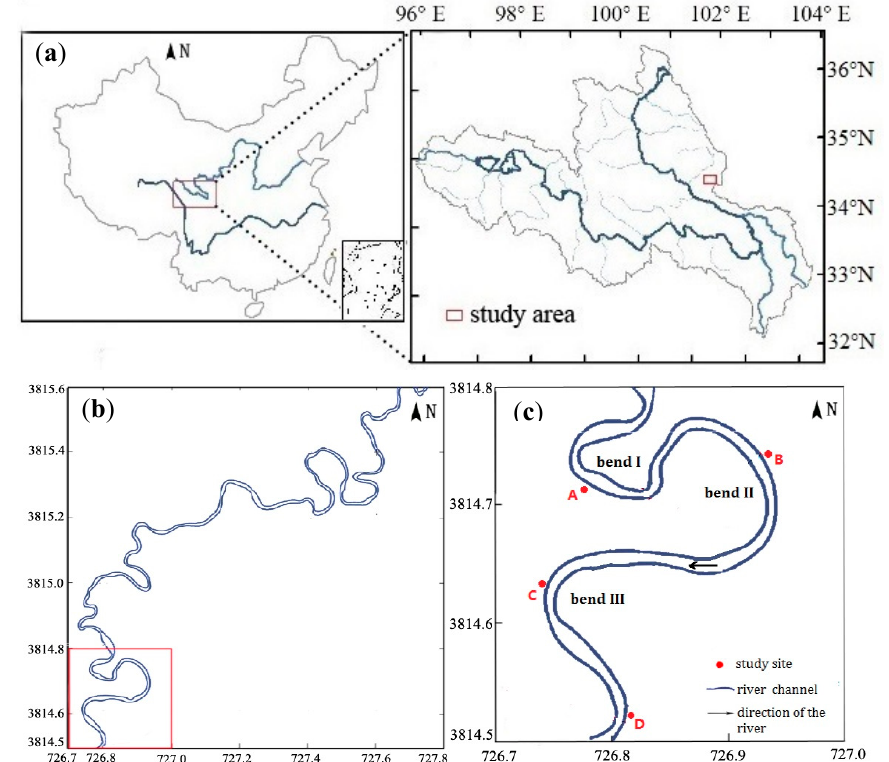
Figure 1. Location of the Lanmucuo River and its highly sinuous bends. ( a ) location of the study site; ( b ) the channel stretch within which bank failures were inspected and measured; ( c ) A, B, C, and D: sites from where soil samples were collected and in situ soil and root properties tests were carried